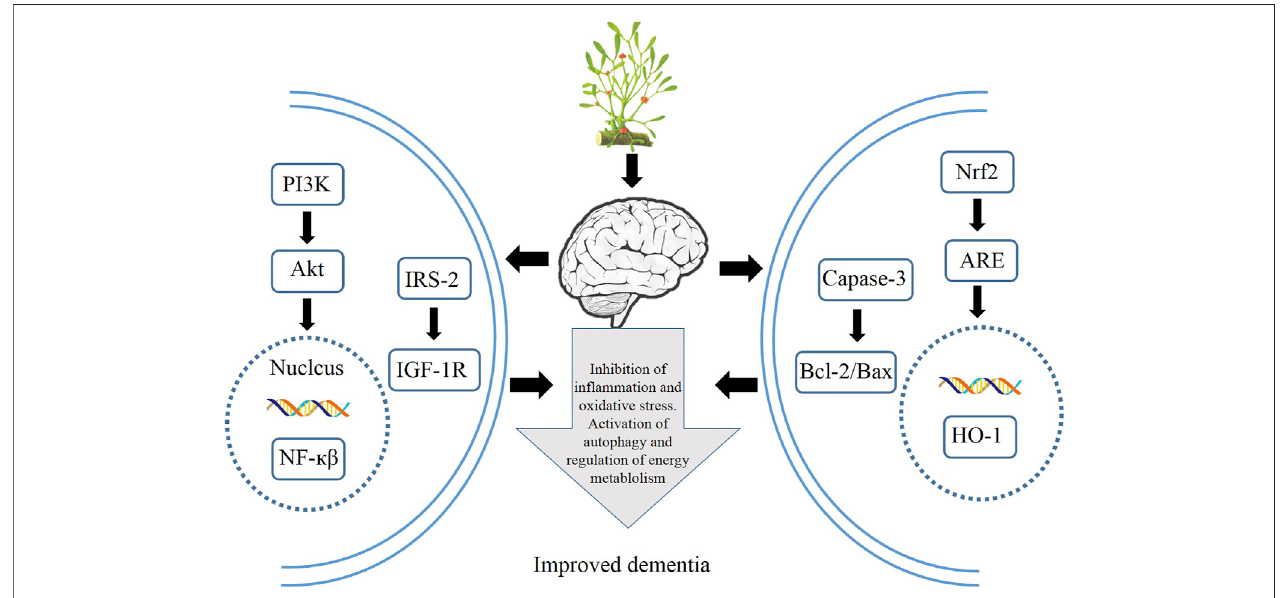
FIGURE 4 | Therapeutic applications of HMs via modulation of autophagy, in fl ammation, oxidative stress, and energy